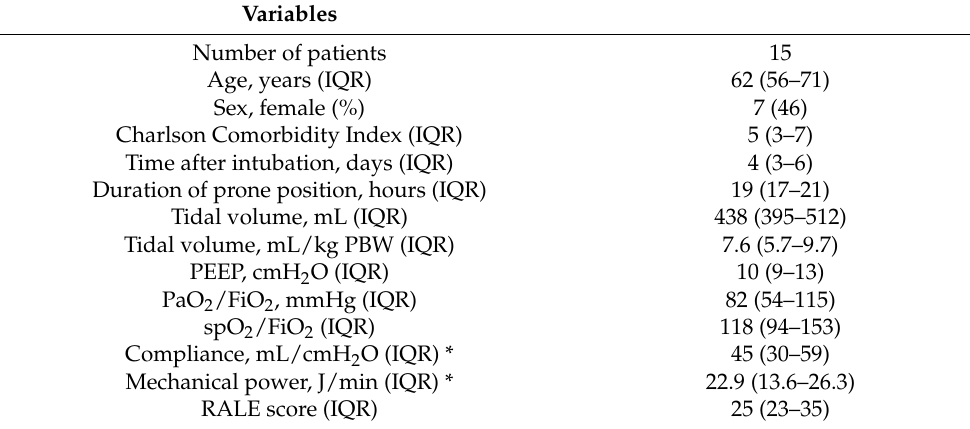
Table 1. Patients’ characteristics.